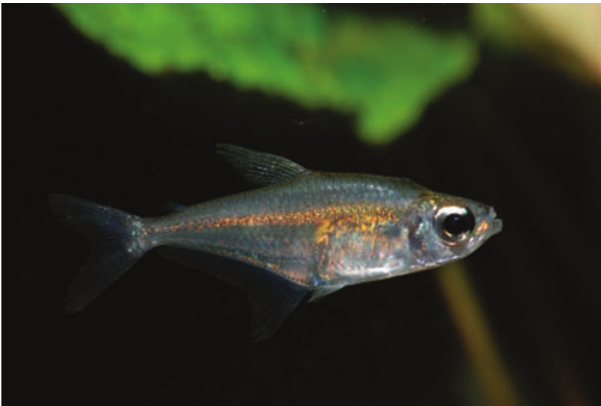
Fig. 1. Heterocharax macrolepis , live specimen photographed in a tank, not